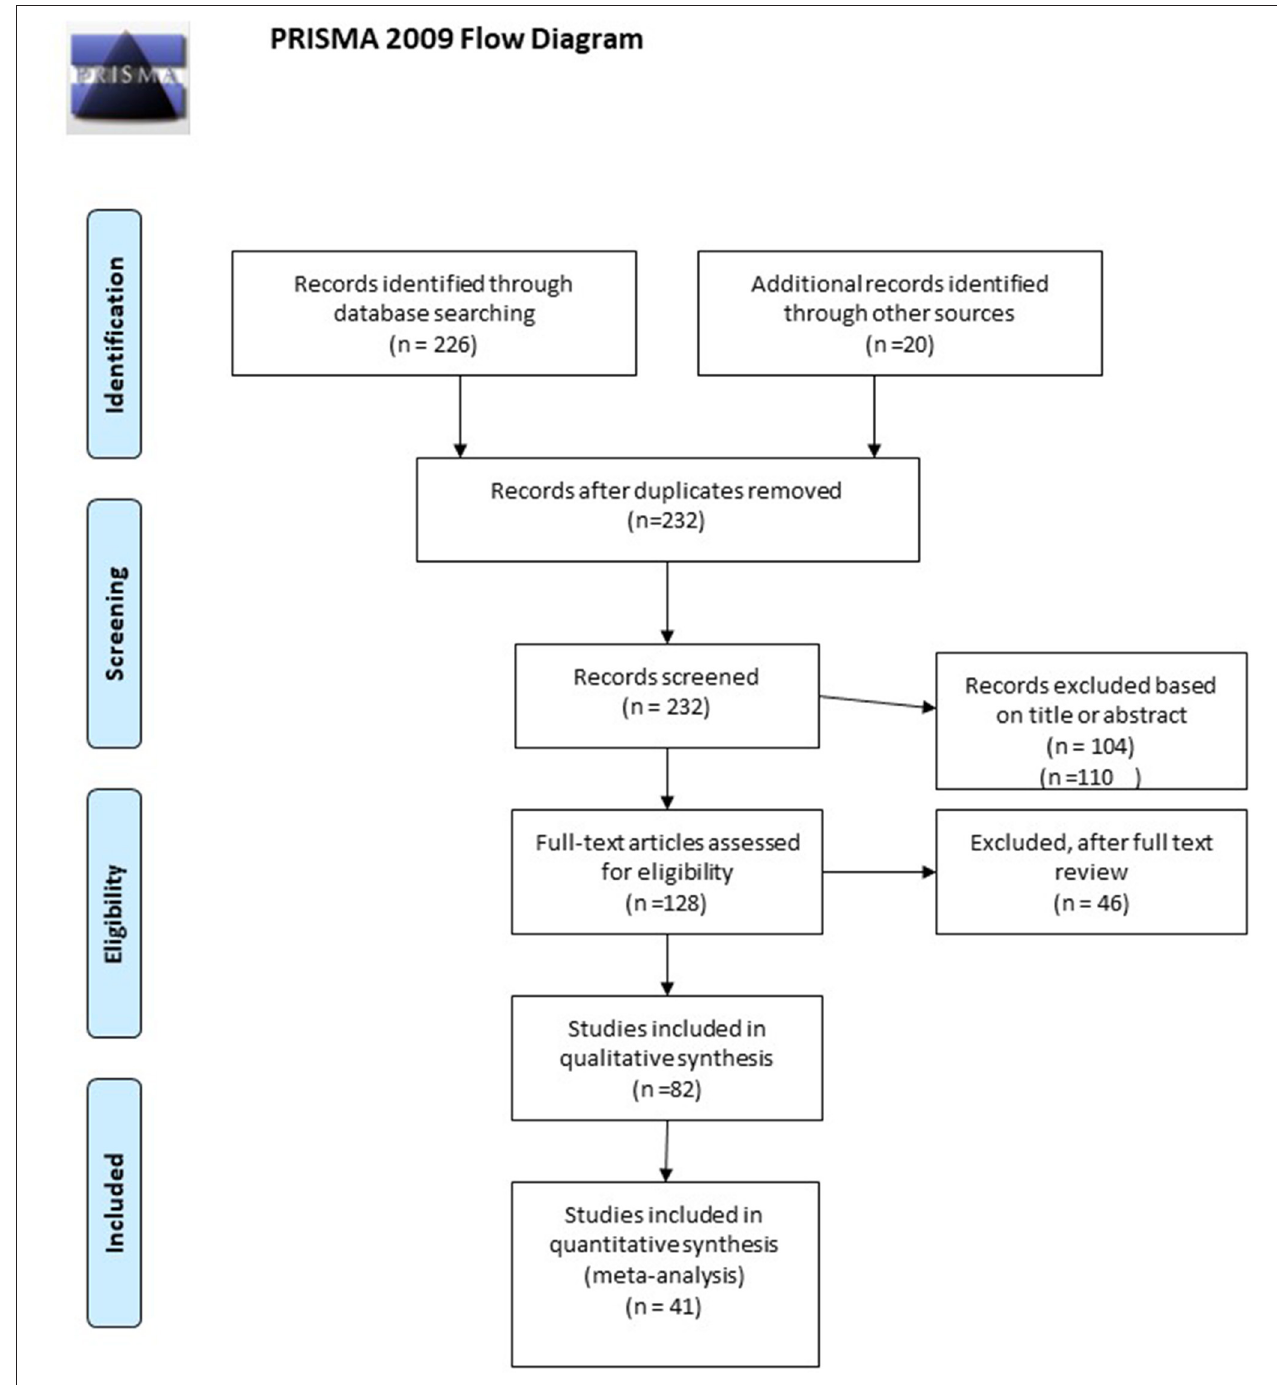
FIGURE 1 | PRIMA flow diagram. Adapted from